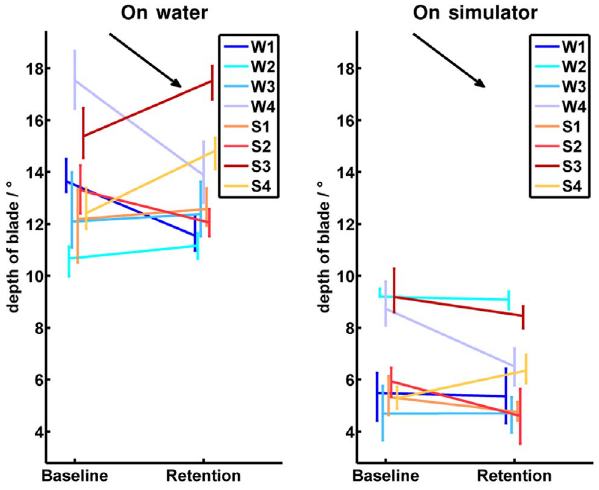
Figure 12. Absolute values of the overlap between trunk and arms. The left half image shows the development of all participants from baseline to retention tests on water, while the right half image illustrates the baseline and retention measurements on the simulator. Participants of the on-water group are indicated by bluish colors and abbreviated by W 1 to W 4 in the legend. Participants of the simulator group are indicated by reddish colors and abbreviated by S 1 to S 4 in the legend. The vertical bars in the baseline and retention tests cover all values performed by the corresponding participant. The measured values in the baseline and the retention tests are connected in the mean values for each participant. The black arrow indicates the direction of the desired development from baseline to retention in the